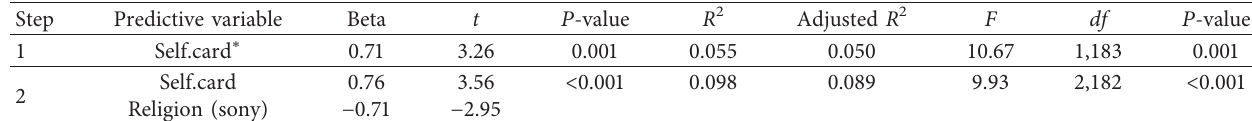
Table 3: Factors affecting nurses’ knowledge of organ donation.